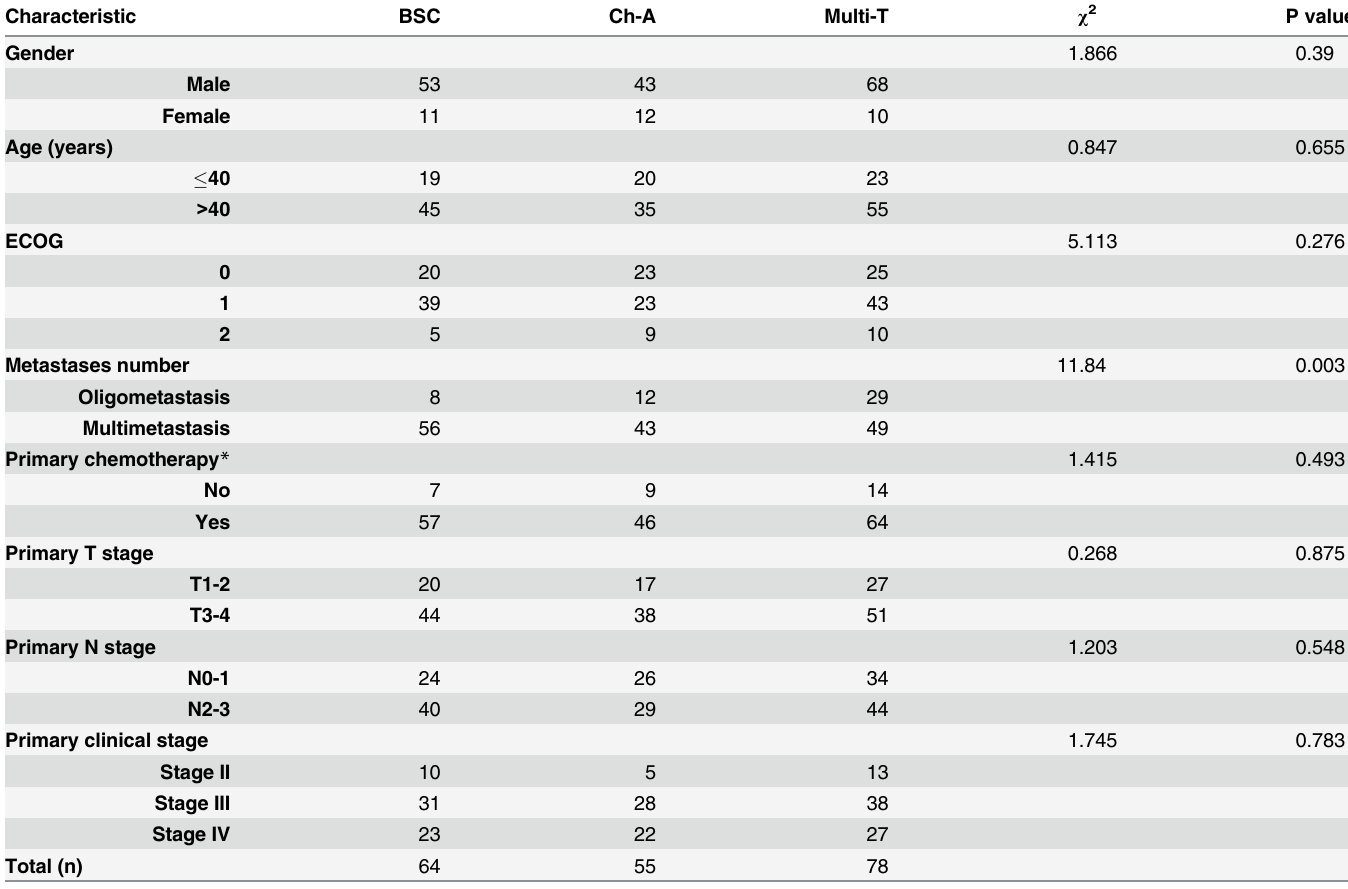
Table 1. Clinical characteristics of patients with NPC developing distant metastasis.